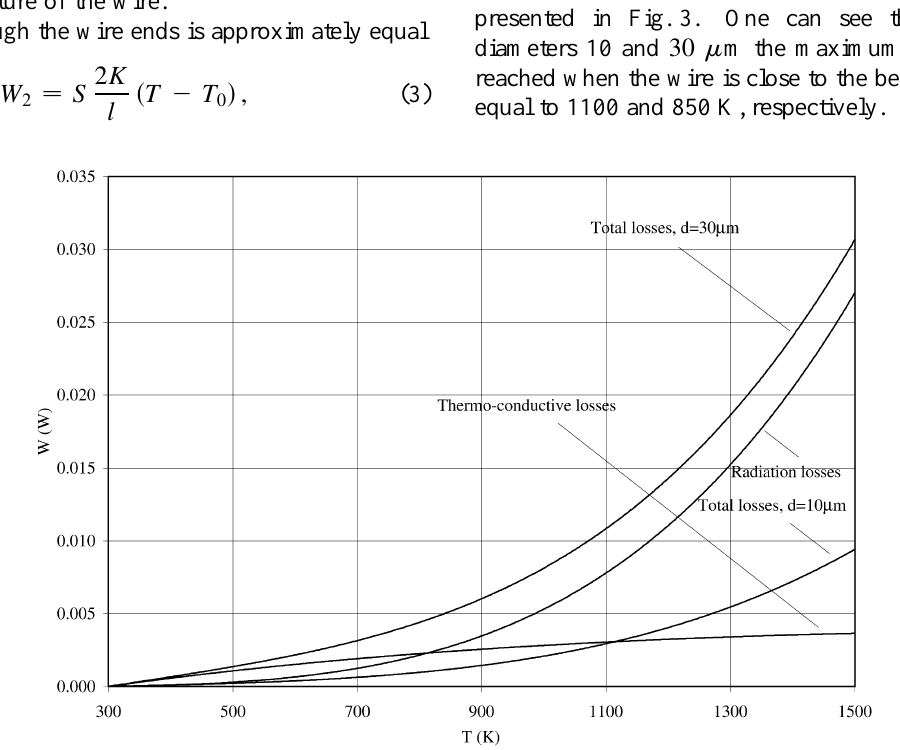
FIG. 1. Total energy losses for tungsten wire, d 1 (cid:1) 30 m m, d 2 (cid:1) 10 m m, l (cid:1) 20 mm, s x (cid:1) 3 mm, s z (cid:1) 1 mm. For the d 1 (cid:1) 30 m m case, radiation losses and thermoconductive losses are also